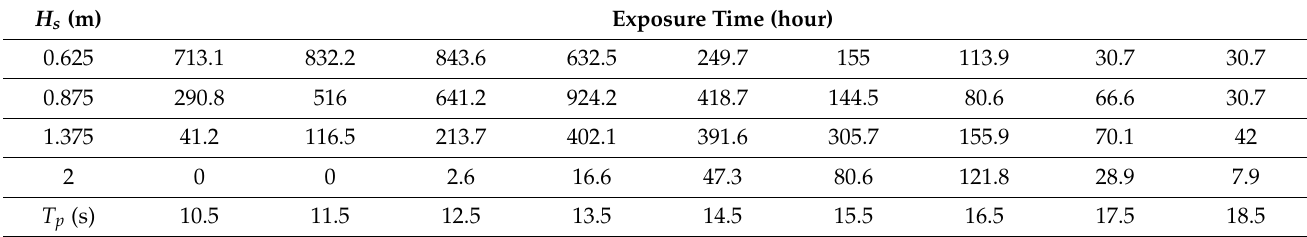
Table 4. Wave height-period distribution of the main swell in West Africa.